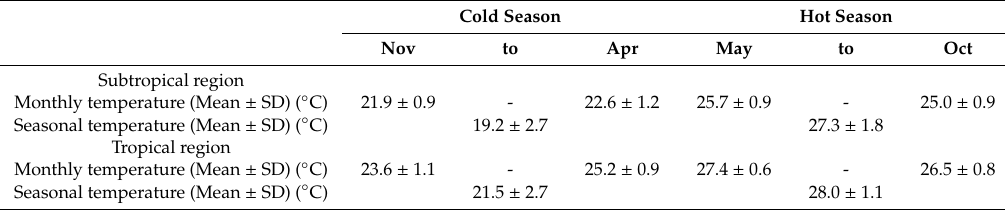
Table 1. Summary of mean daily temperature from January 1997 to December 2011 in Taiwan.